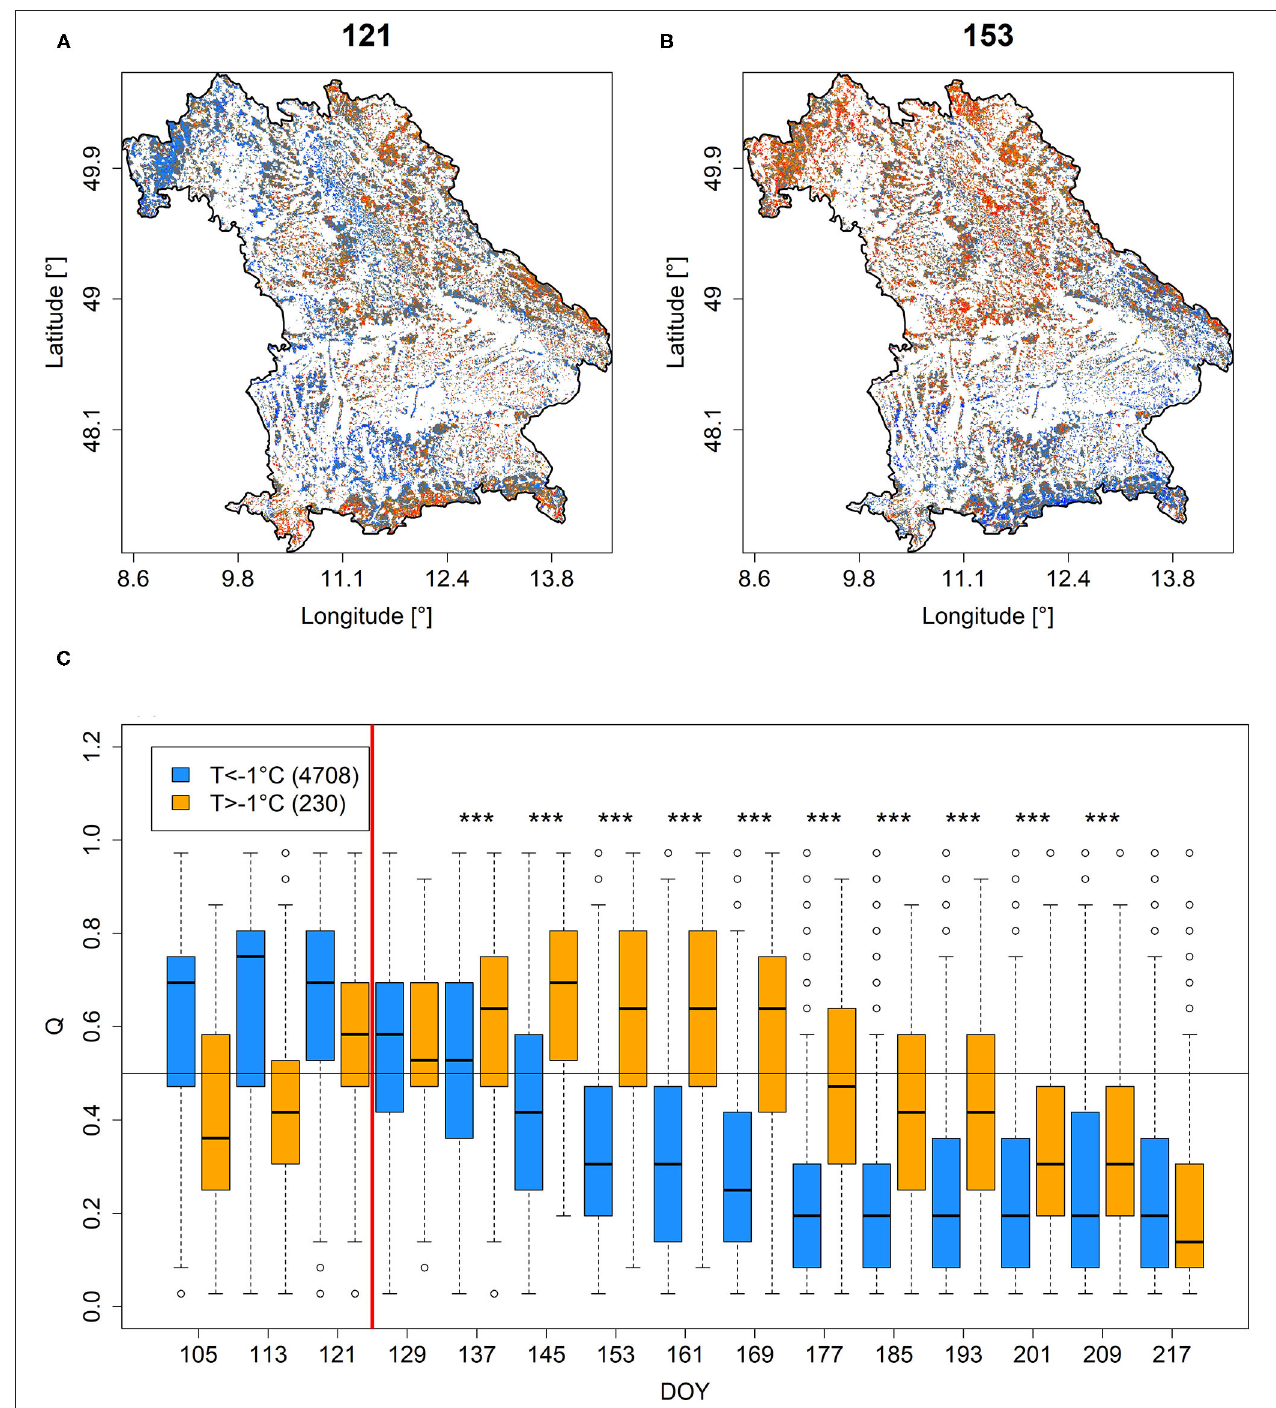
FIGURE 4 | Q for DOYs 121 (A) and 153 (B) in 2011. (C) Times-series depicting Q -values extracted for each time step between DOY 105 and DOY 217 for pixels featuring more than 45% beech cover and minimum temperatures at DOY 124 (indicated by vertical red line) below (blue) or above (orange) − 1 ◦ C (for minimum temperature distributions at DOY 124, see Supplementary Figure 6 ). ***Stars indicate significant differences ( p < 0.001). A similar figure but for PDM is shown in Supplementary Figure 5 .